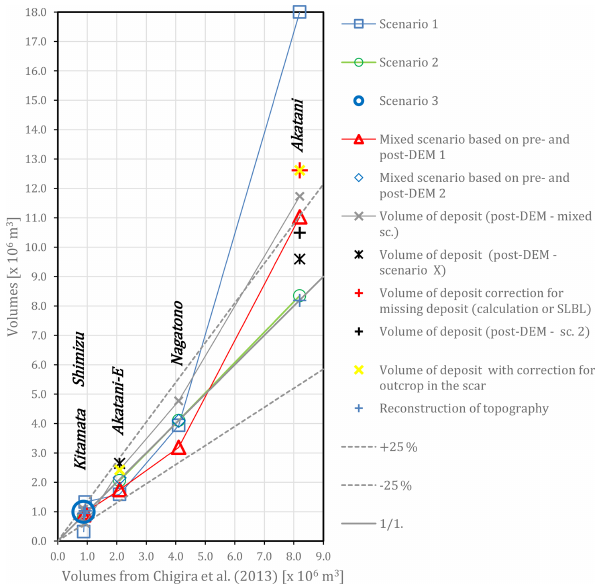
Figure 25. All attempts to calculate the volumes of the five land- slides in relation to the volume defined by Chigira et al.